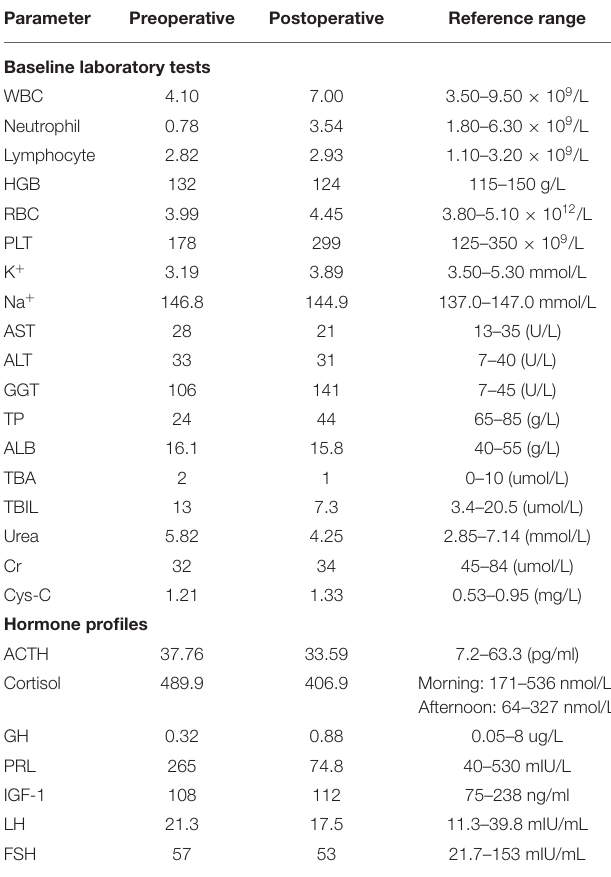
TABLE 1 | Preoperative and postoperative results of baseline laboratory tests and hormone